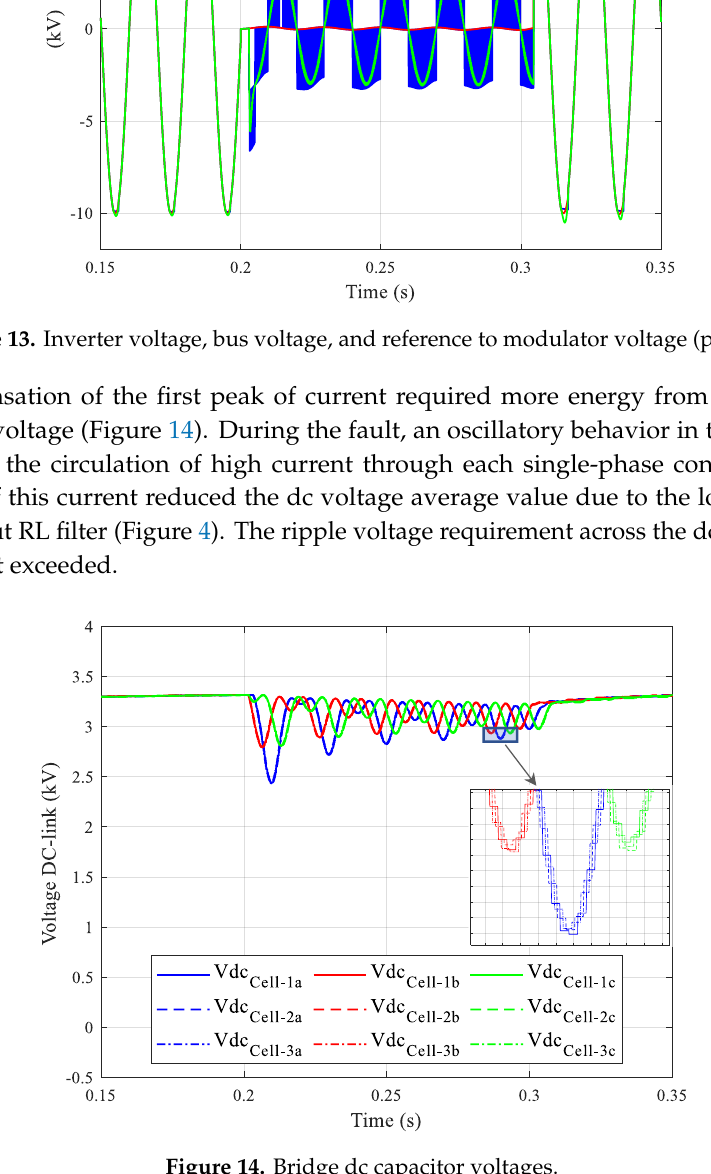
Figure 15. Current error, current reference waveform, and PFCA output current (phase a). In Figure 16a,b the operation of the PFCA for three-phase short circuits at different fault times is shown, proving the PFCA ’s adaptability and compensation effectiveness. The results show that the PFCA compensation performance is independent of the fault time and the fault current waveform in each phase.